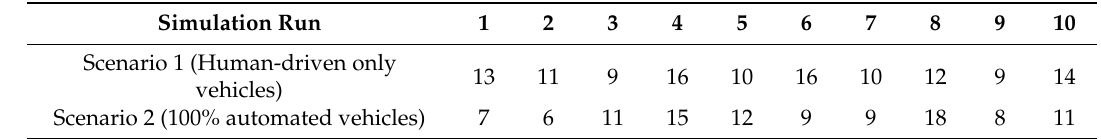
Table 2. Number of conflicts per simulation run and